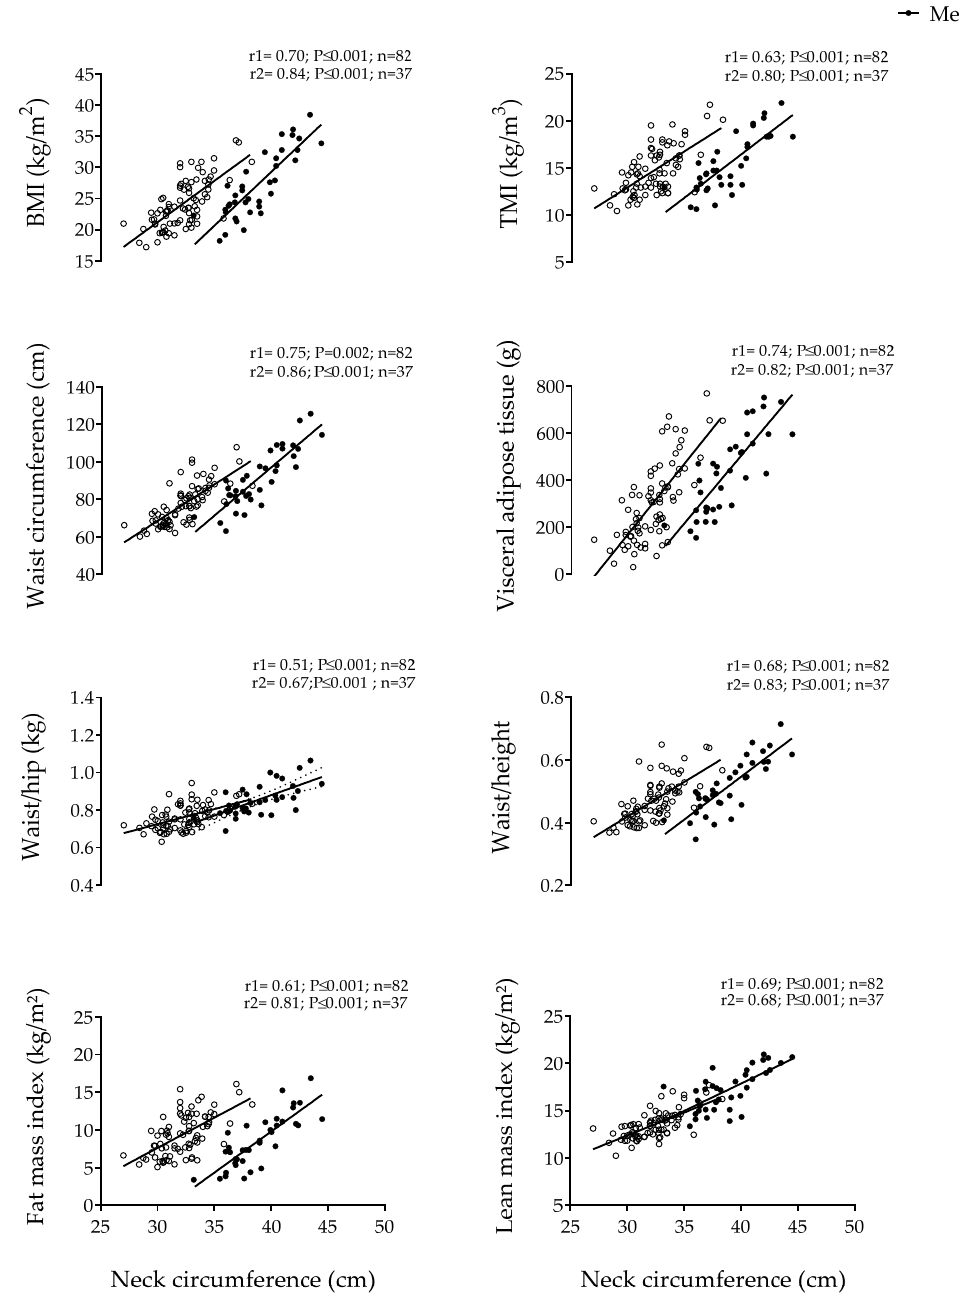
Figure 1. Association of neck circumference with indicators of anthropometry and body composition by sex (women: n = 82, men: n = 37). BMI: Body mass index; TMI: Triponderal mass index.